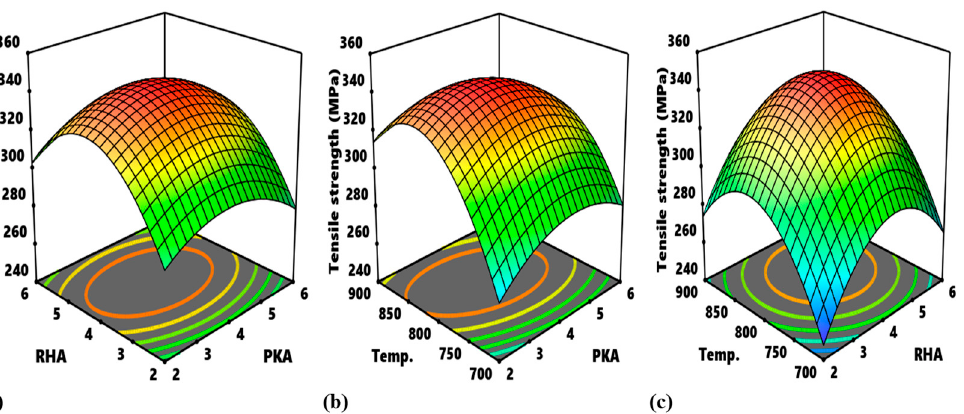
Figure 9. Surface plots representing the relationship of the variables that affect tensile strength as revealed by interactions ( a ) PKA vs. RHA ( b ) PKA vs. stirring temperature ( c ) RHA vs. stirring temperature.